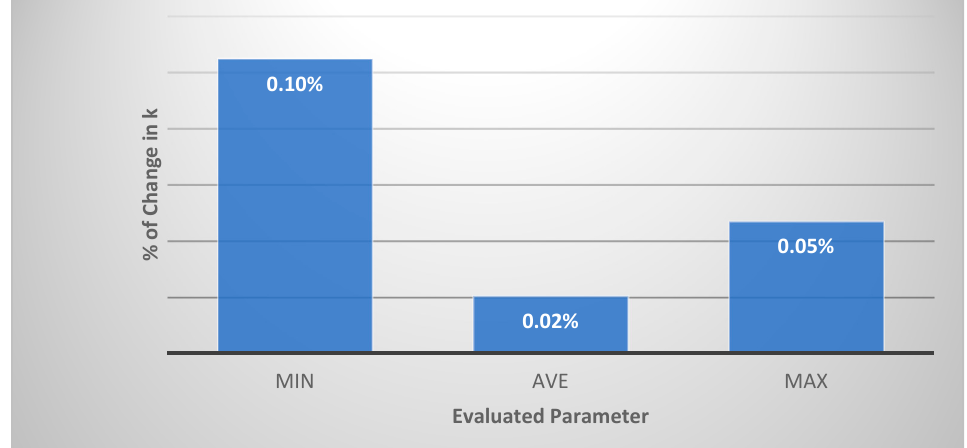
Figure 5. GCI Analysis (Medium to Fine Set).